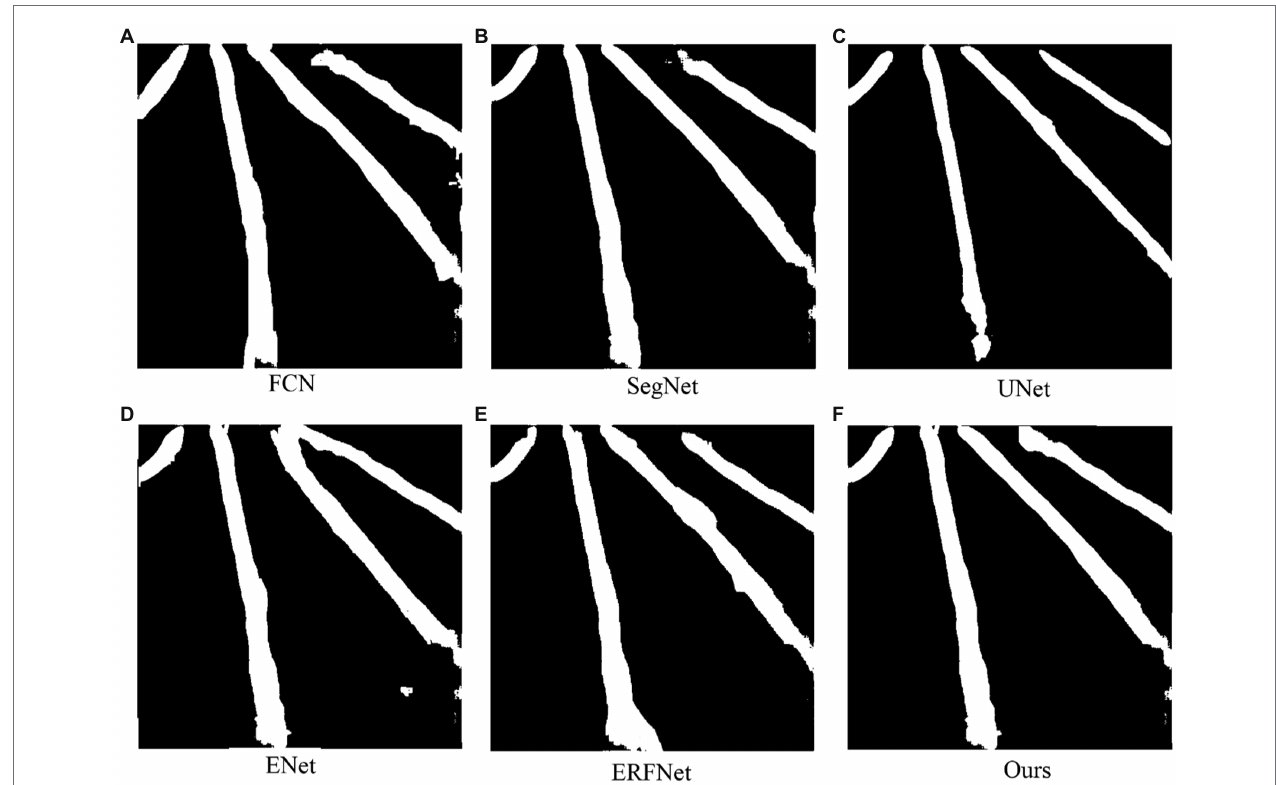
FIGURE 8 | Example segmentation results for each trained model. (A) Example of FCN model segmentation results. (B) SegNet model segmentation result example. (C) UNet model segmentation result example. (D) ECN model segmentation result example. (E) ERFNet model segmentation result example. (F) This paper proposes an improved model segmentation result